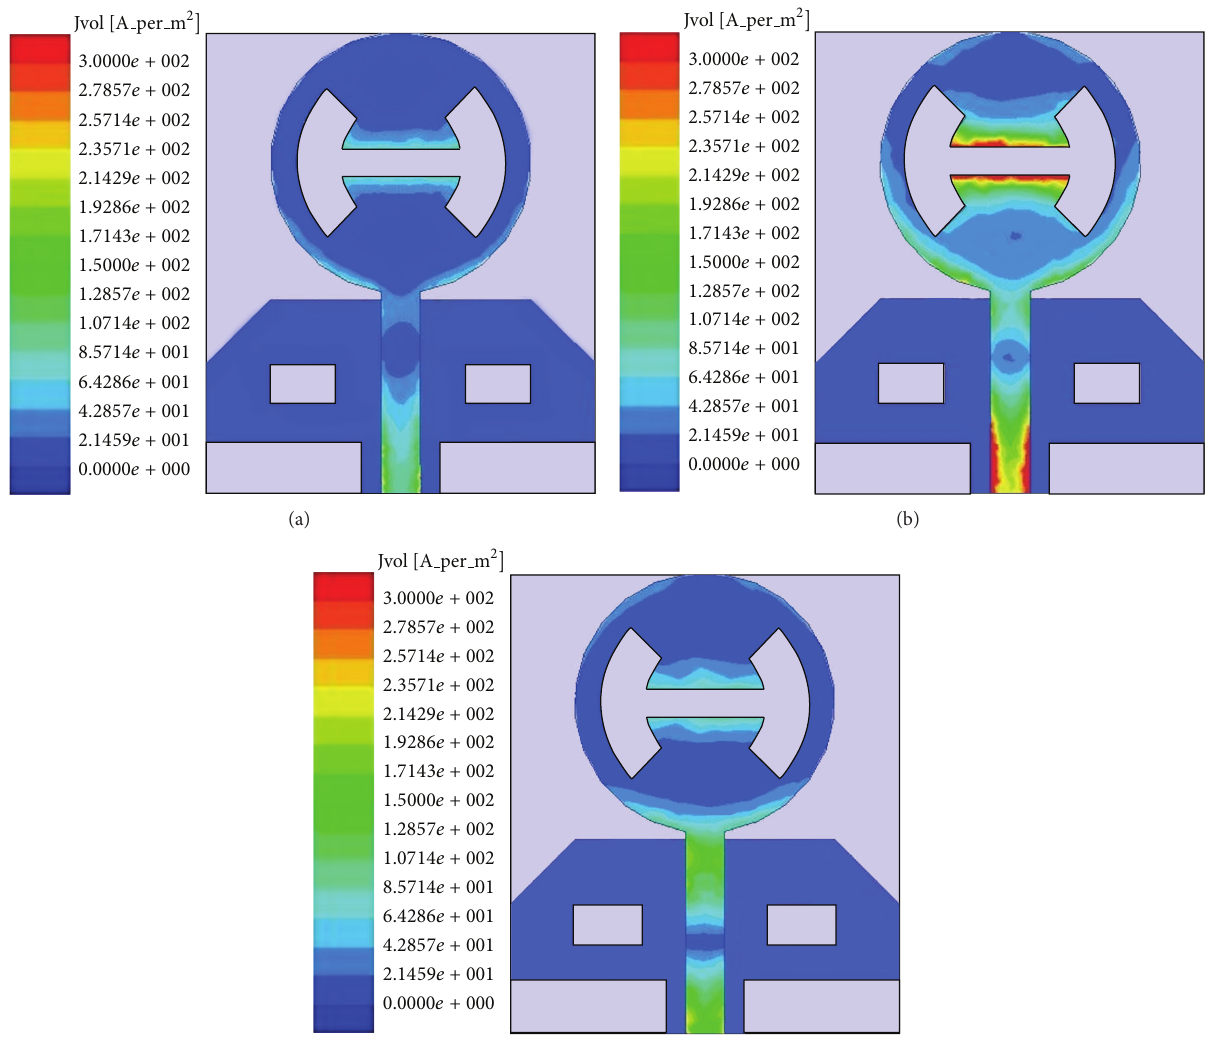
Figure 5: Surface current distribution of the antenna: (a) 3.2 GHz, (b) 3.7 GHz, and (c)